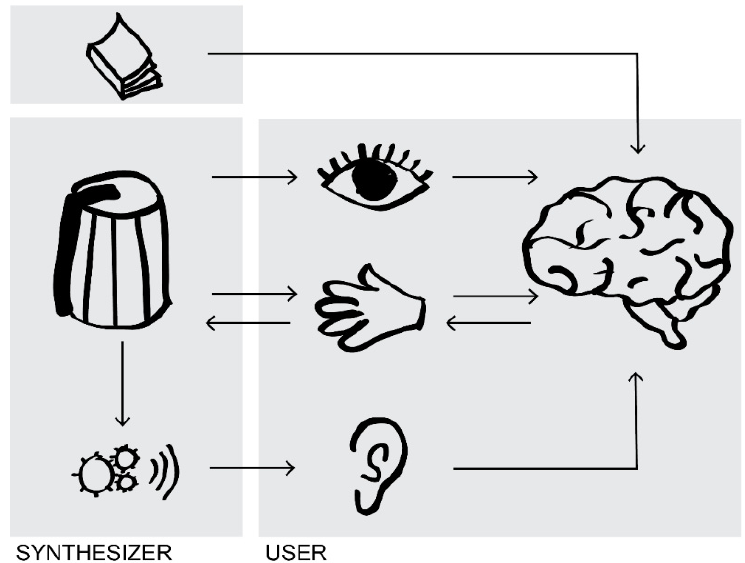
Figure 7. Knob interaction